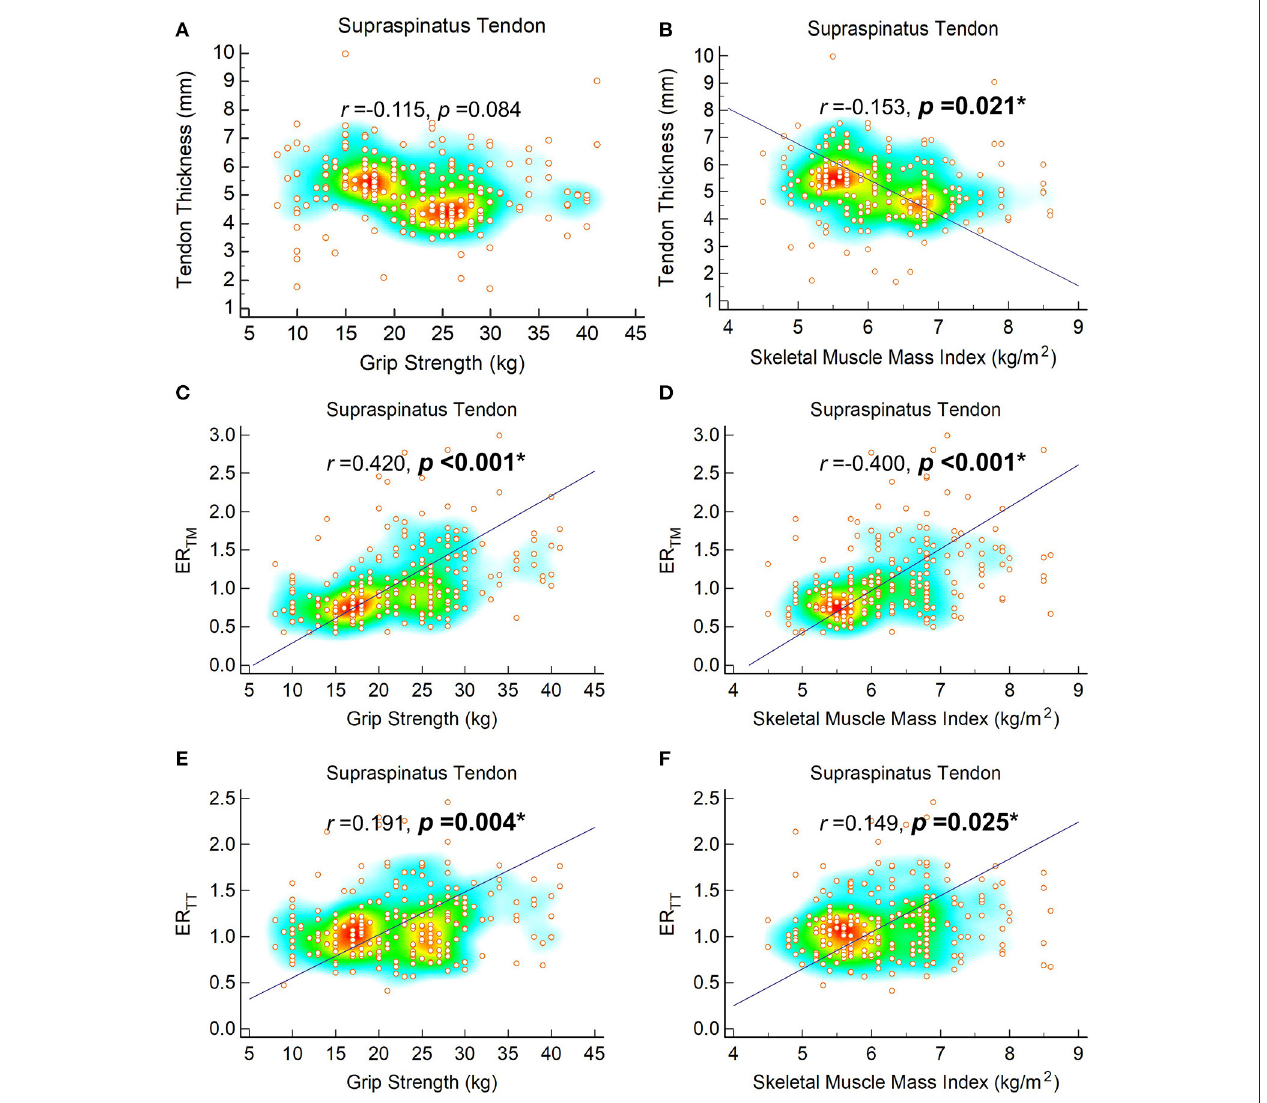
FIGURE 2 | Correlation of tendon thickness with grip strength (A) and skeletal muscle mass index (B) , ER TM with grip strength (C) and skeletal muscle mass index (D) and ER TT with grip strength (E) and skeletal muscle mass index (F) of the supraspinatus tendons. The regression line is plotted on when p -value is < 0.05. The heat map with background color coding suggests clusters of observations. ER TM , echogenicity ratio of the tendon vs. the overlying deltoid muscle; ER TT , echogenicity ratio of the tendon vs. the overlying subcutaneous